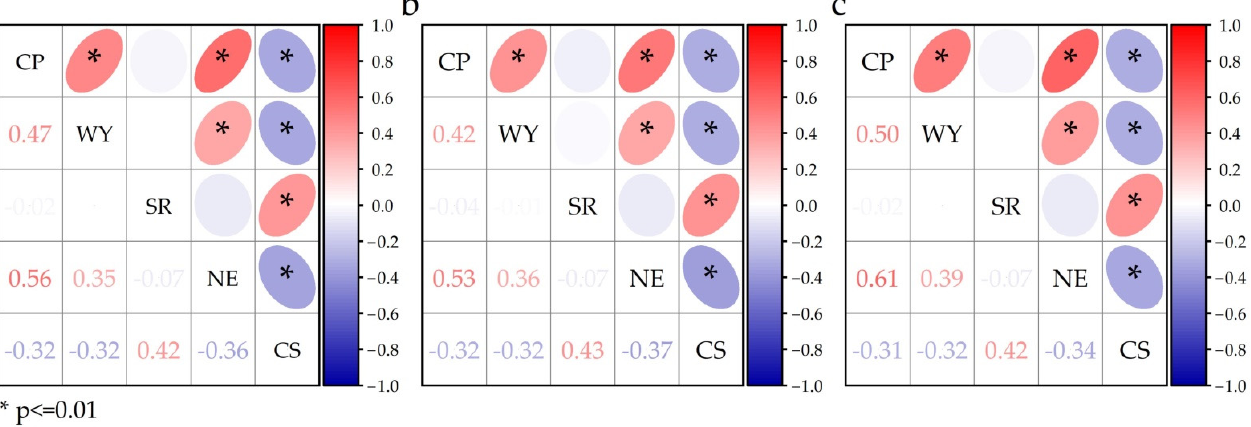
Figure 9. Trade-offs among ecosystem services under three scenarios in 2030: ( a ) BAUS; ( b ) EDS; ( c ) EPS. (CP, crop production; WY, water yield; SR, soil retention; NE, nitrogen export; CS, carbon